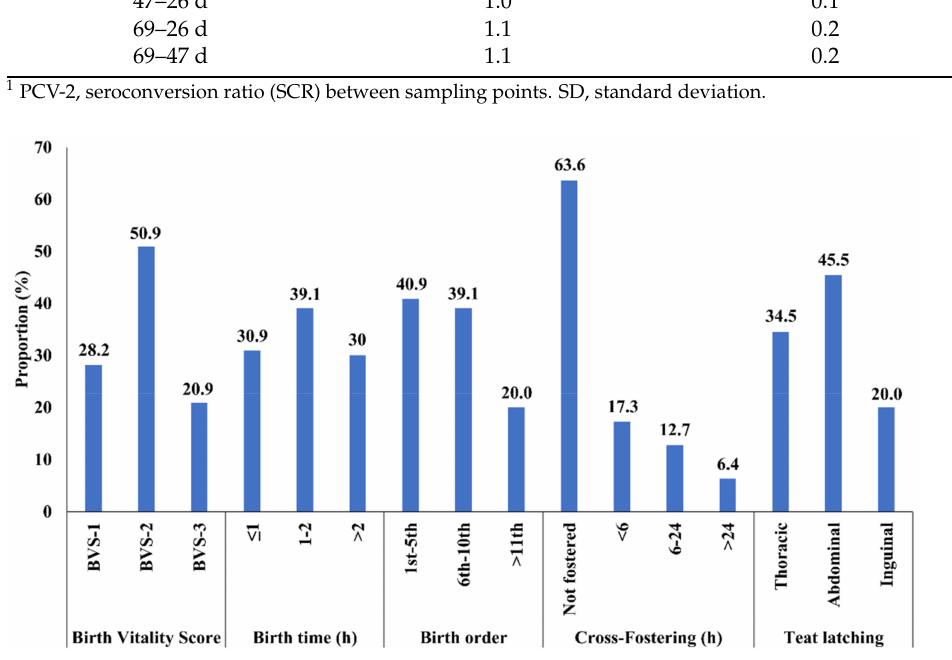
Figure 3. Proportion of study piglets ( n = 110) classified in the covariates measured during the preweaning and postweaning periods. BVS1: breathed and not moved during the first 15 s of life; BVS-2: breathed and moved within 15 s of life; BVS-3: breathed, moved, and tried to stand up during the first seconds of life. Birth time (h) relative to the first piglet born. Cross-fostering (h) after birth. Table 2. Adjusted HCR linear regression estimates associated with study